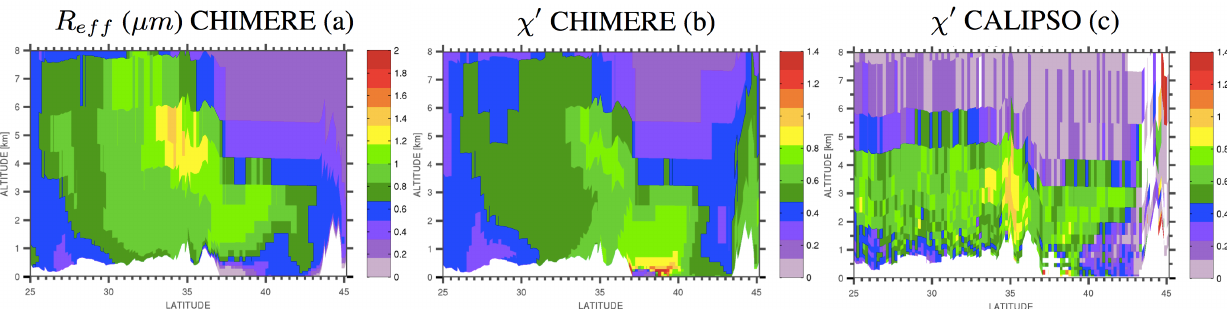
Fig. 15. Effective Radius and Color Ratio by CHIMERE (a, b) and Color Ratio CALIOP (c) for the nighttime portion of the orbit of the 9 July 2007. The initial profiles corresponding to cloud contaminated data are filtered out. The cloud-free data are averaged into the model’s horizontal and vertical resolutions for comparison to the simulated R 0 (z) profiles.